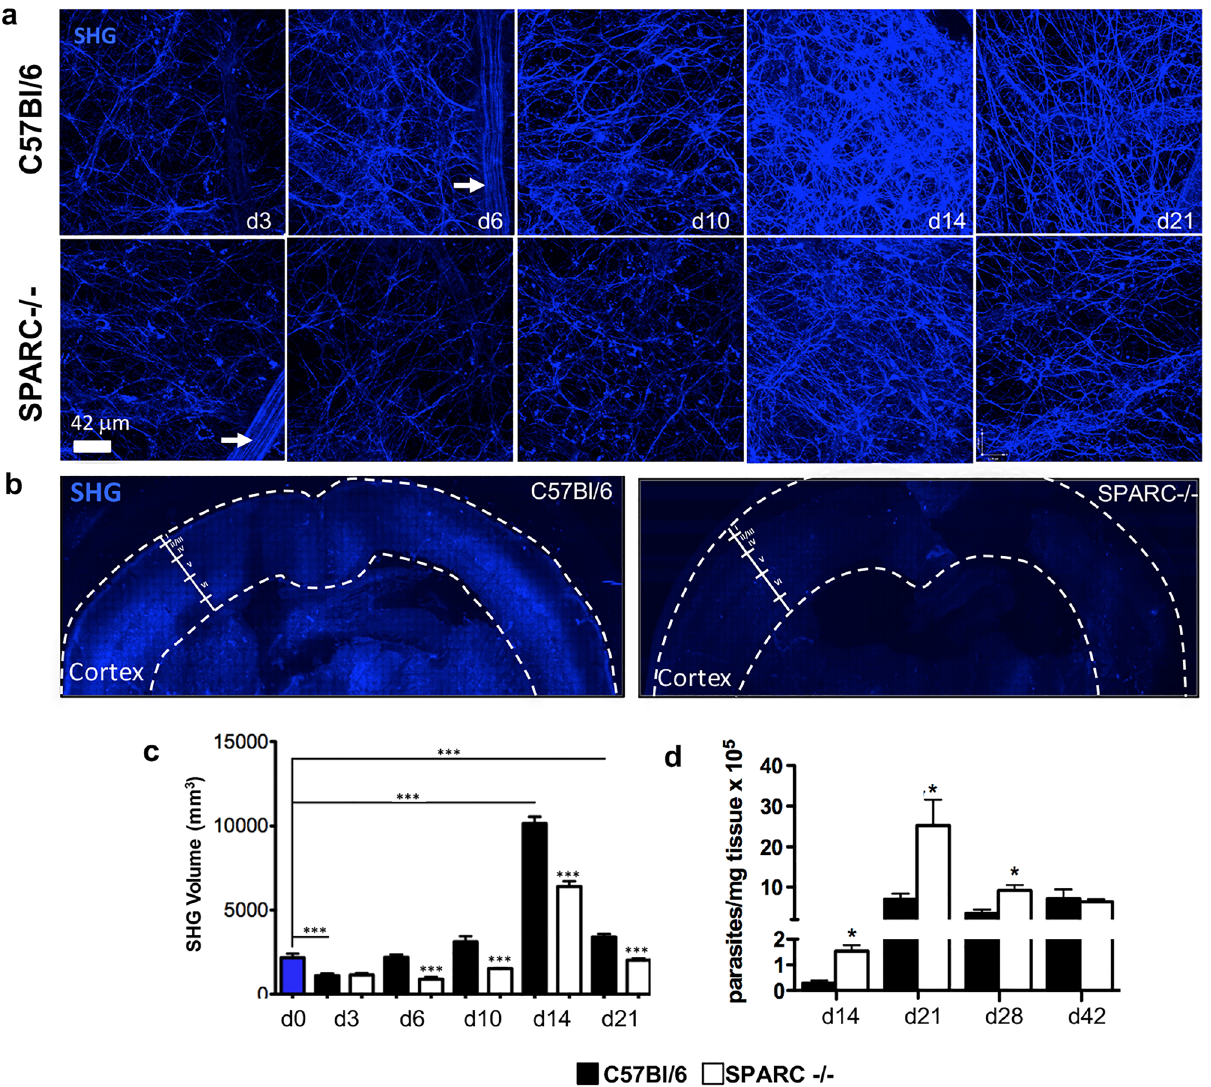
Figure 3. SPARC−/− mice have compromised reticular fiber network in the brain during chronic T. gondii infection. C57Bl/6 and SPARC−/− mice were infected and sacrificed at 3, 6, 10, 14, and 21 days following infection. Brains were removed and imaged on a multiphoton microscope for second harmonic generation (SHG) signal. ( a ) 30 μm z-stacks were obtained at various locations of the cortex. 3D images were compiled and reticular fibers were analyzed for volume ( c ). Blood vessels (white arrows) were excluded from analysis. ( b ) Brains were excised from mice at 14 days post infection and images of whole coronal sections were generated by stitching overlapping Z stacks collected over the entire section. ( d ) C57Bl/6 and SPARC−/− mice were infected and sacrificed at 14, 21, 28, and 42 days following infection. DNA was isolated from the brain and analyzed for parasite burden using qPCR. Results are displayed as parasites per mg tissue. Data are representative of at least 2 individual experiments with a minimum of n = 4 mice per group and are represented as mean ± SEM. Volumes and parasite burden were analyzed using the student’s T test, *** p <